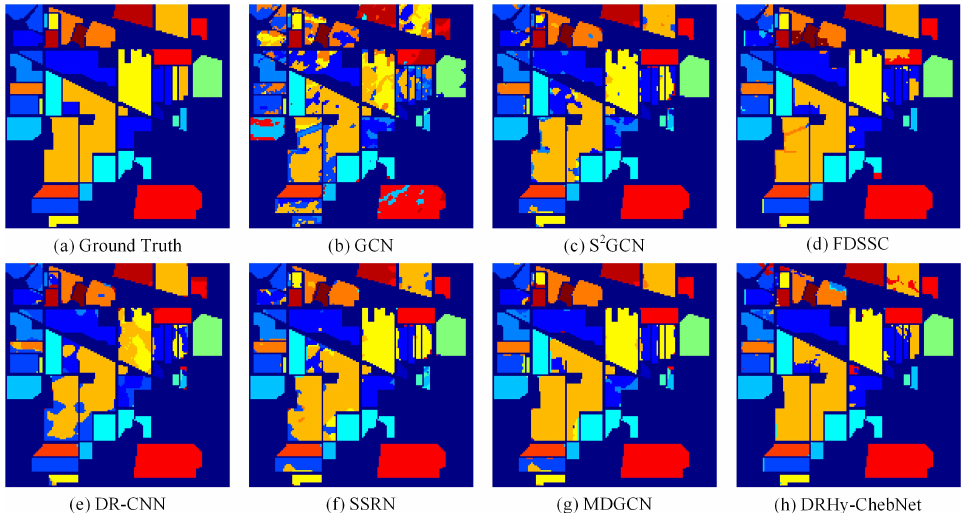
Figure 4. Classification results of different methods on the Indian Pines dataset. ( a ) Ground truth. ( b ) GCN. ( c ) S 2 GCN. ( d ) FDSSC. ( e ) DR-CNN. ( f ) SSRN. ( g ) MDGCN. ( h ) The proposed DRHy- ChebyNet